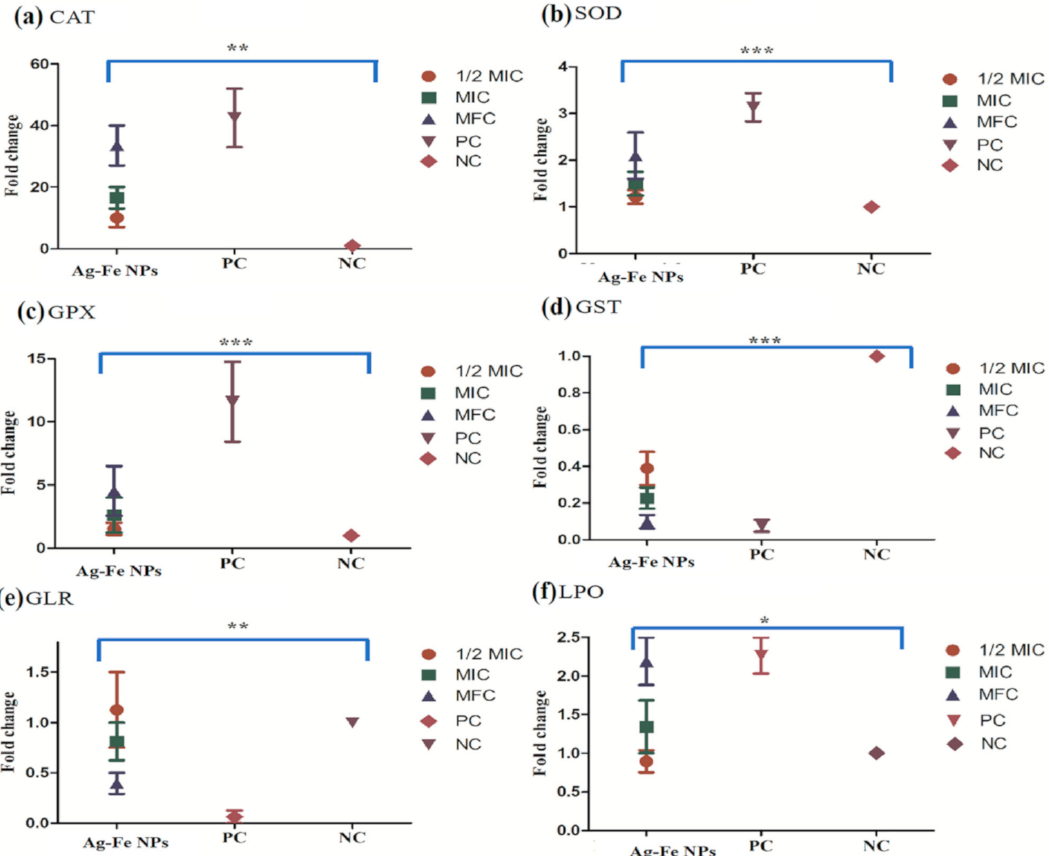
Figure 10. Antioxidant enzyme activity of C. auris . The effects of 0.19 µ g/mL ( 1 / 2 MIC), 0.39 µ g/mL (MIC) and 0.78 µ g/mL (MFC) on the activity of different antioxidant enzymes in C. auris MRL6057. ( a – f ) represent catalase, superoxide dismutase, glutathione peroxidise, glutathione transferase, glutathione reductase and lipid peroxidation respectively. * p ≤ 0.001; ** p ≤ 0.005; *** p ≤